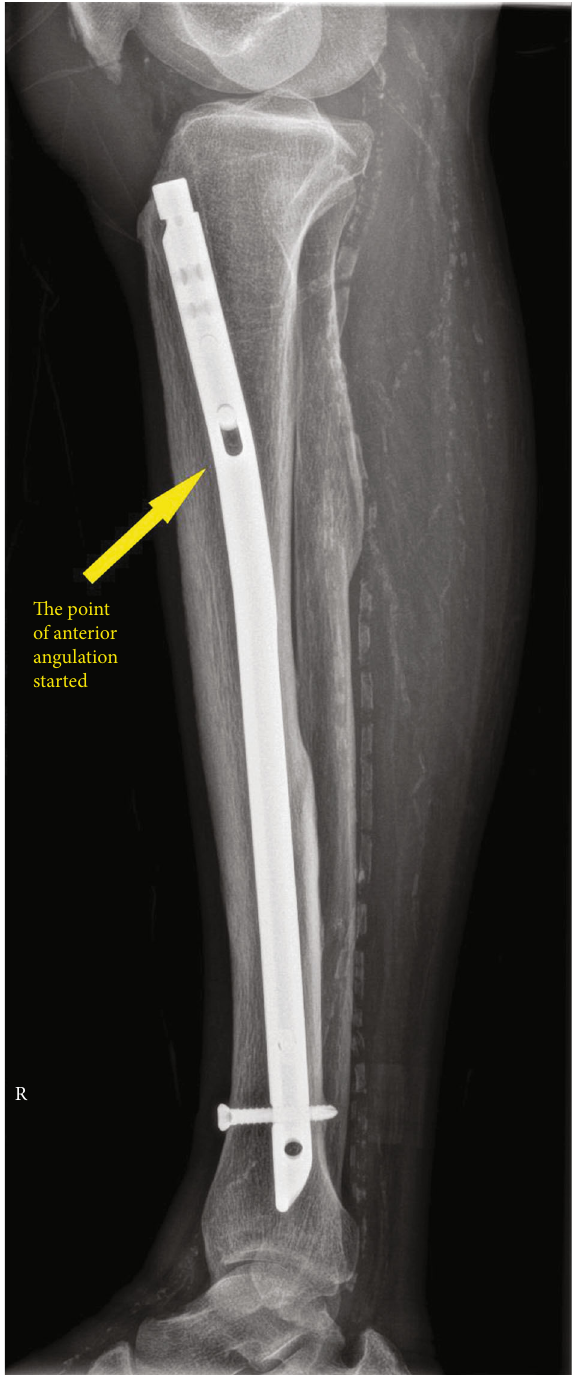
Figure 2: Lateral view of the tibial plain radiograph. The point of the anterior angulation started about 10cm away from the tibial plateau.